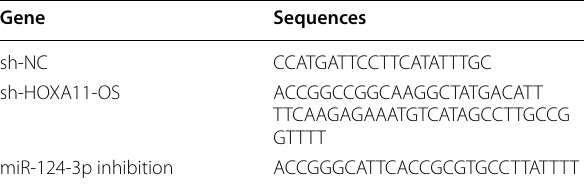
Table 1 Gene sequences used in animal